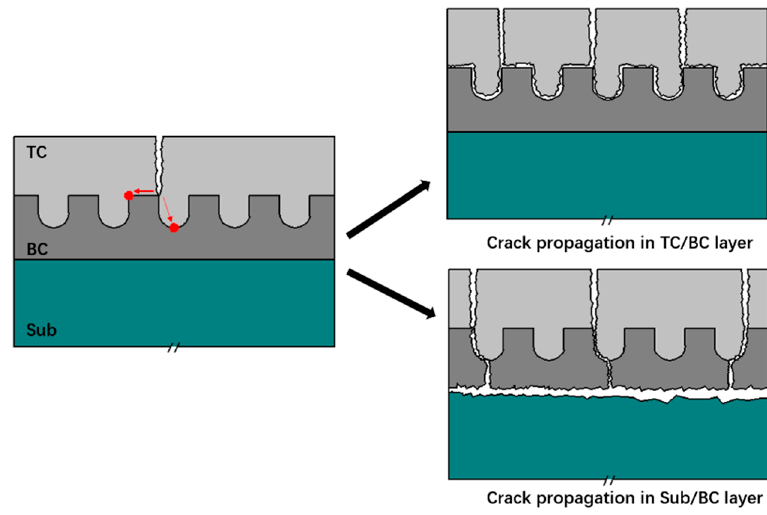
Figure 9. Schematic illustration of crack propagation.